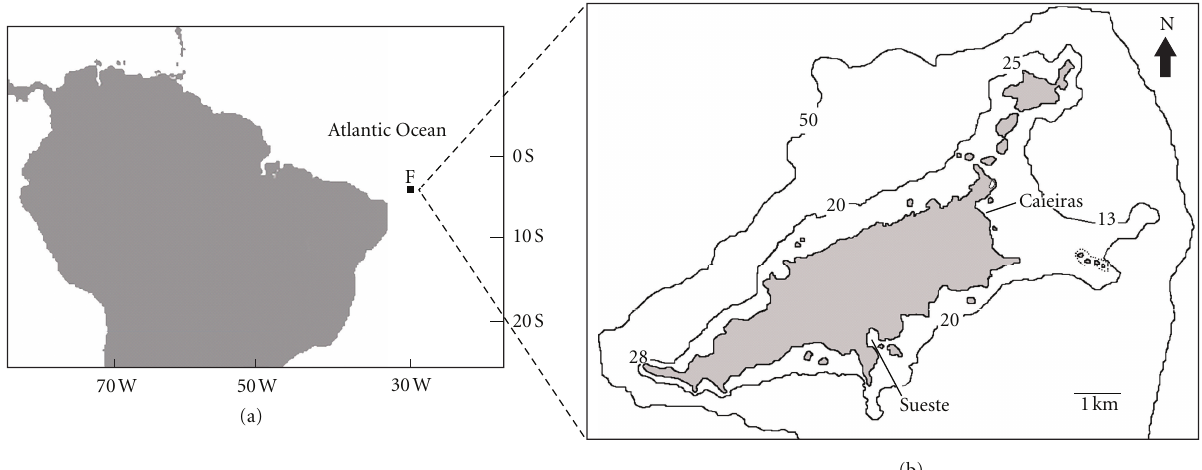
Figure 1: Geographical localization of study sites (Caieiras and Sueste) at the main island of Fernando de Noronha archipelago, o ff northeastern Brazil, where seaweeds were